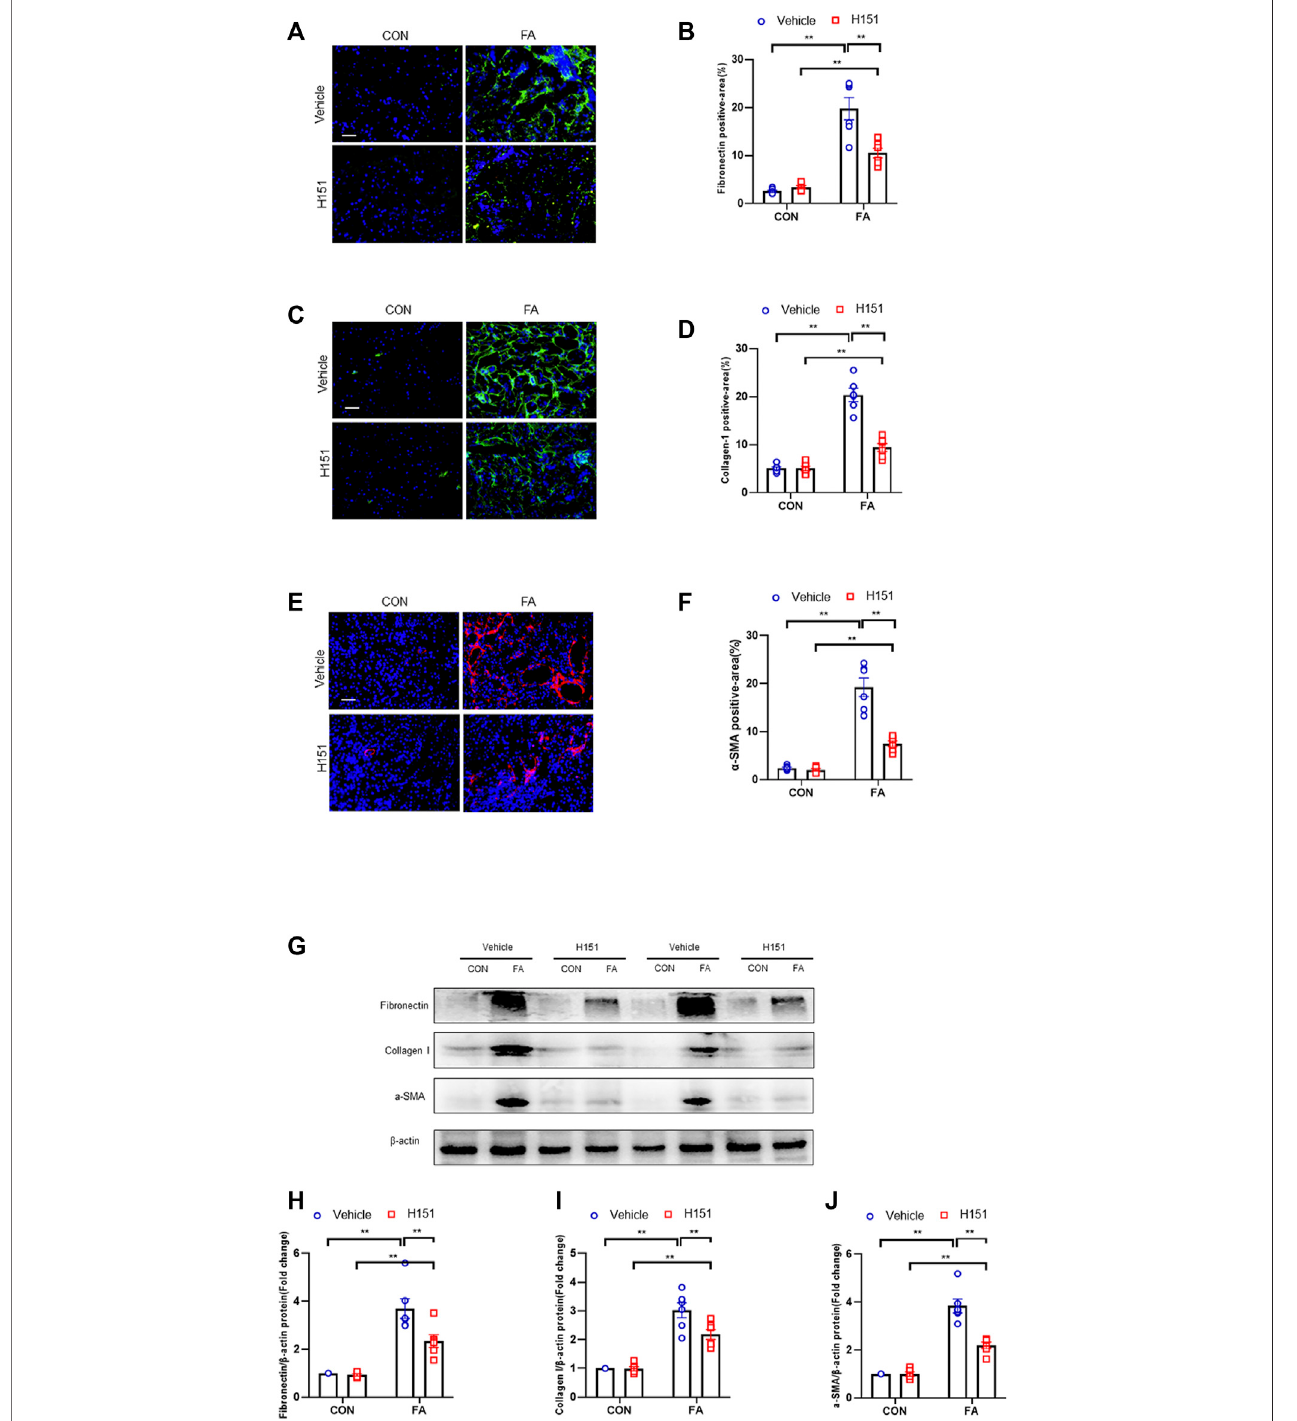
FIGURE 4 | Pharmacological inhibition of STING reduces ECM proteins expression and fi broblasts activation in FA nephropathy. (A) Representative immuno fl uorescence photomicrographs of kidney sections in each group stained for fi bronectin (green) and DAPI (blue). (B) Quantitative analysis of fi bronectin-positive area in the kidneys. (C) Representative photomicrographs of kidney sections in each group stained for collagen I (green) and DAPI (blue). (D) Quantitative analysis of collagen I-positive area in the kidneys. (E) Representative immuno fl uorescence photomicrographs of kidney sections in each group stained for α -SMA (red) and DAPI(blue). (F) Quantitativeanalysisof α -SMA-positiveareainthekidneys. (G) Representativewesternblotsshowthelevelsof fi bronectin,collagenI,and α -SMAprotein expression in each group. (H – J) Quantitative analysis of fi bronectin, collagen I, and α -SMA protein expression levels in the kidneys. ** p < 0.01, * p < 0.05; n = 6 in each group; Scale bar: 50 μ